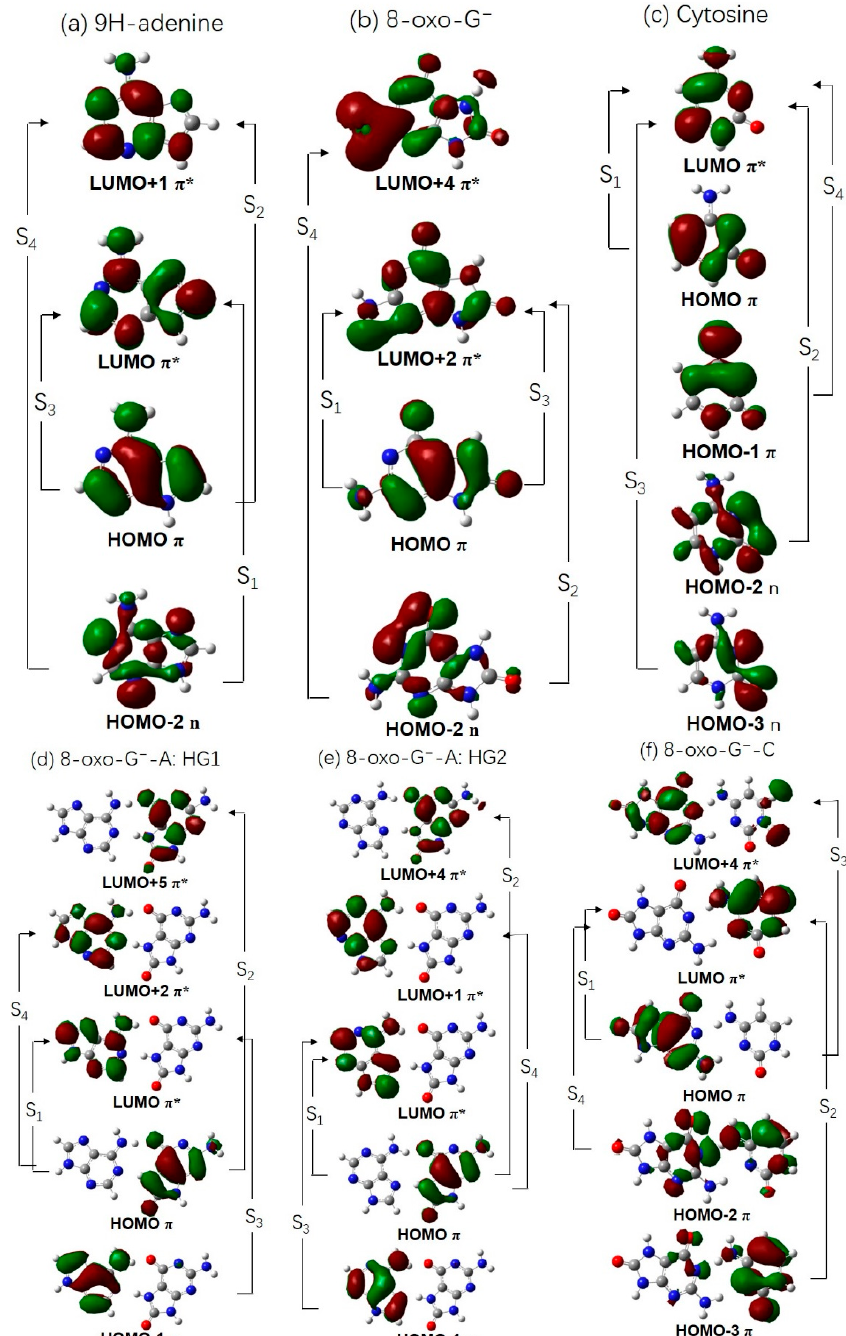
Figure 2. Orbitals and orbital promotions involved in forming the lowest four excited states of 9 H - adenine ( a ), 8-oxo-G − ( b ), cytosine ( c ), and the three base pairs ( d – f